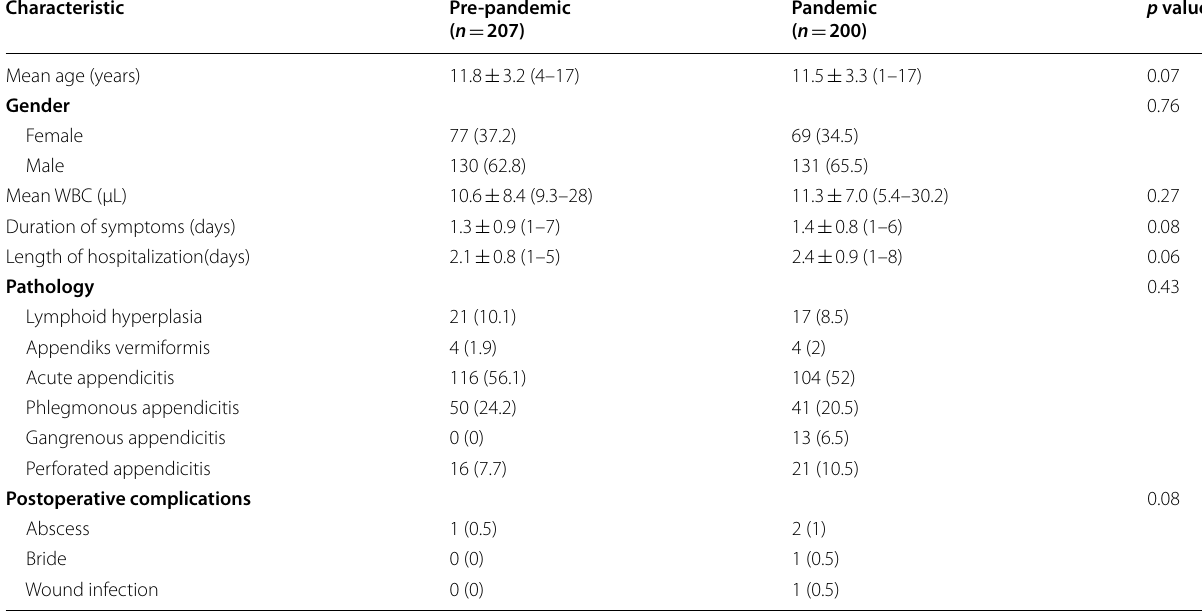
WB C White blood cell